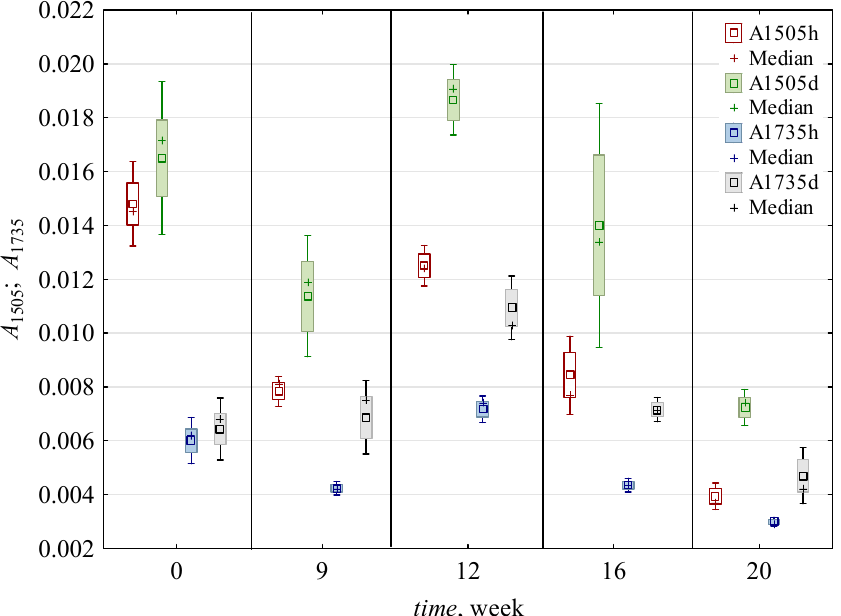
Figure 3. Value of absorbance A 1505 for wavenumber characteristic for lignin and A 1735 for hemicelluloses; h —peak height, d —peak deconvolution, □ —mean, frame—standard error ( SE ), and whisker—standard deviation ( SD ).